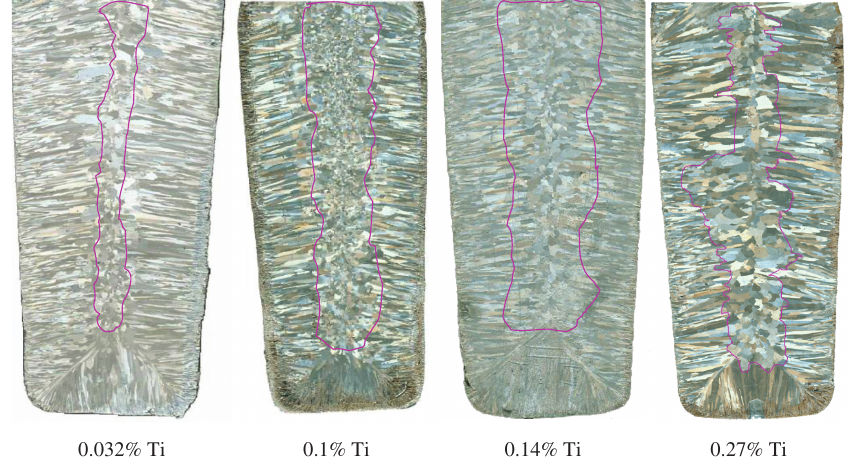
Figure 2: Solidification structure of steel containing the different Ti contents.